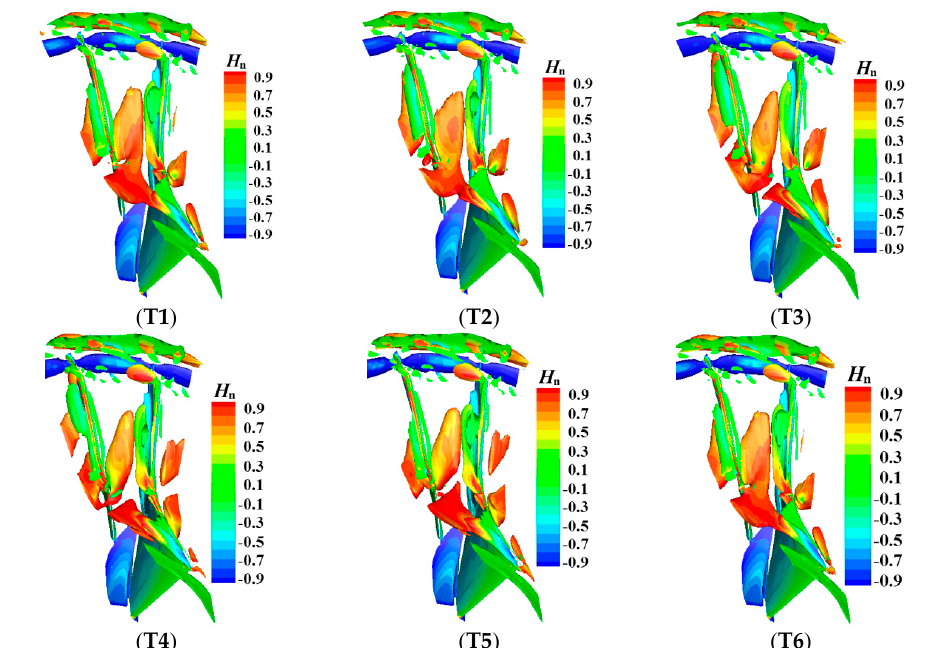
Figure 3. Variation in vortex structures with time.